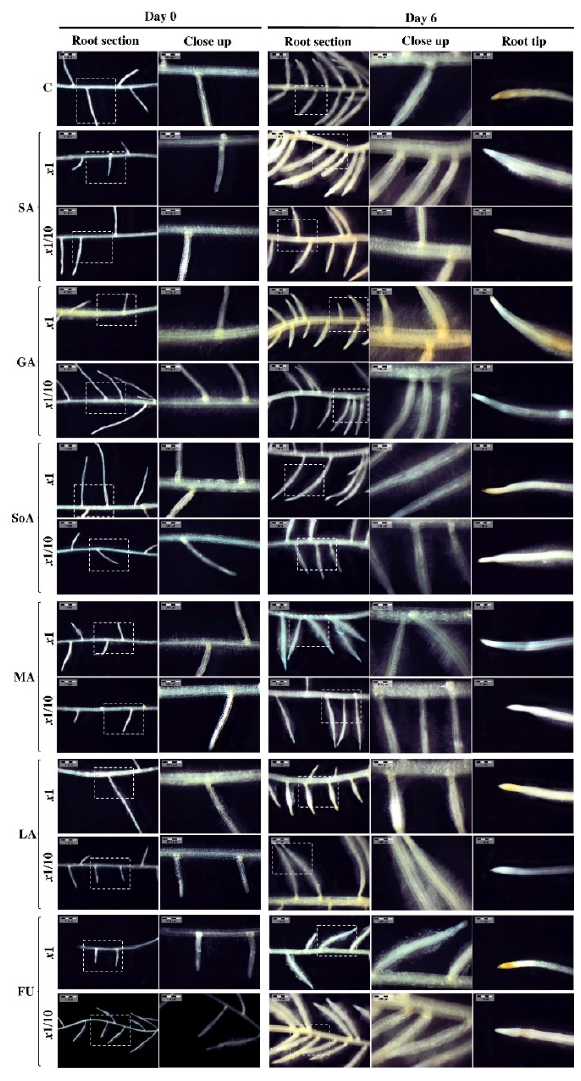
Figure 3. Root morphology of tomato plants treated with organic compounds (salicylic acid (SA), gallic acid (GA), sodium alginate (SoA), mannitol (MA), laminarin (LA), and fucose (FU)) at two concentrations ( × 1/10 and × 1) after 0 and six days of Fe deficiency. A control (C) treatment without organic compound application was performed. The scale applied to the photos and the close ups are 1 and 0.5 mm,